Question: Sum up the contents of this chart in one sentence.
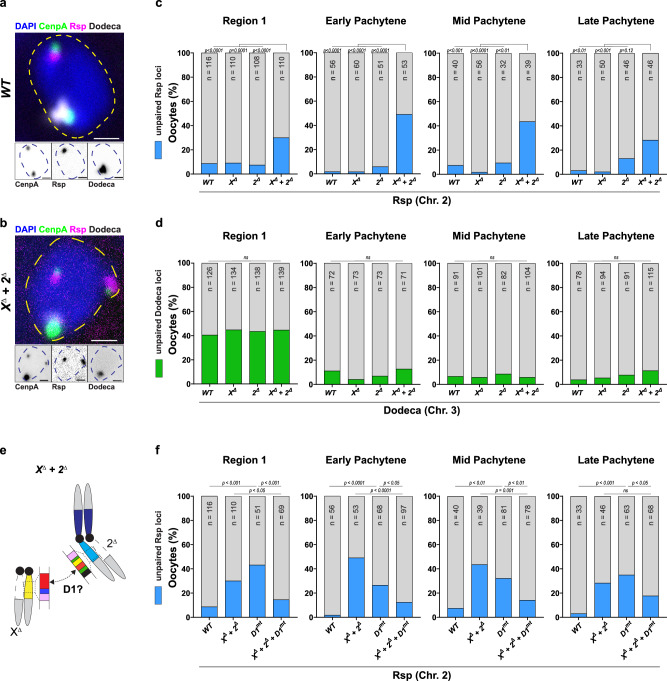
Answer: Loss of meiotic centromere pairing at chromosomes carrying satellite DNA deletions. a , b DNA FISH against the Chr. 2 specific Rsp satellite repeat (magenta) and the Dodeca satellite repeat (white) in mid-pachytene oocytes from the WT strain ( a ) and the double deletion strain ( b ) and co-stained with DAPI (blue) and dCenp-A (green). c , d Quantification of oocytes with unpaired Rsp (c) and Dodeca (d) loci in region 1, early, mid, and late pachytene from the indicated genotypes. e Schematic showing non-homologous associations between identical satellite DNA repeats (red) in the double-deletion strain, potentially mediated by the satellite DNA-binding protein D1. f Quantification of oocytes with unpaired Rsp loci in region 1, early, mid, and late pachytene from the indicated genotypes. n indicates the number of oocytes analysed, and p- values were obtained from a two-sided Fisher’s exact test. ns indicates p > 0.05. All scale bars are 1 µm. Source data are provided as a Source Data file. p- values of individual comparisons can be found in Supplementary Data 1 .